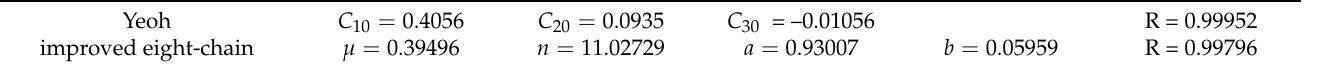
Figure 15. Nominal stress versus strain on Przybylo and Arruda data in uniaxial compression and characterization results for the Yeoh model and the improved eight-model. ( a ) Fitting results of uniaxial compression data; ( b ) extended compression range and predicted tension showing the instability of the Yeoh model and the improved eight-model. Table 7. Constants determined from nonlinear regression